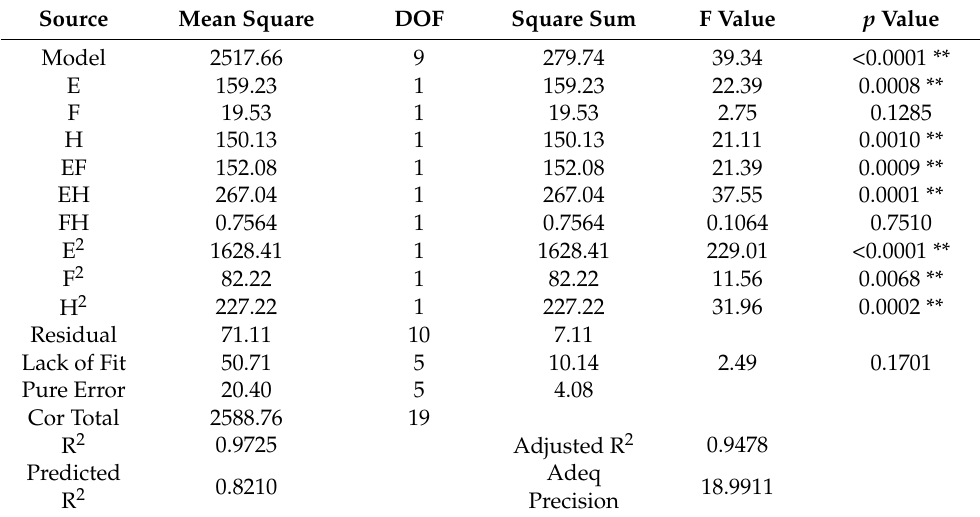
Table 10. G 1 model of quadratic regression model analysis